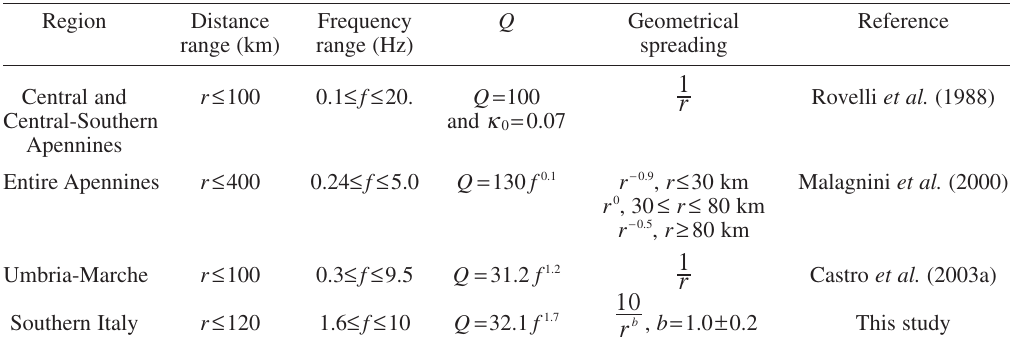
Table III. S -wave attenuation relations reported for